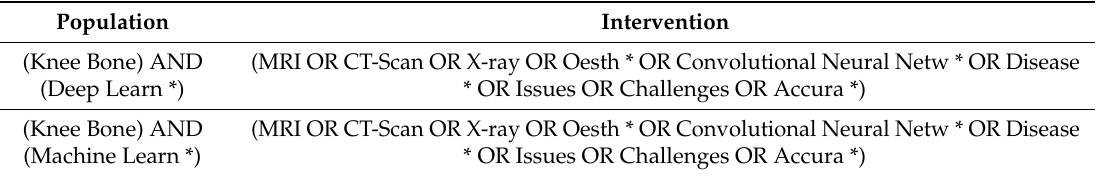
Table 2. String search.